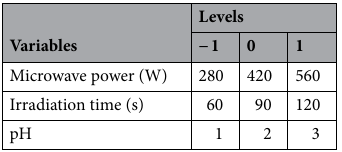
Table 1. Variables and levels used for Box-Behnken